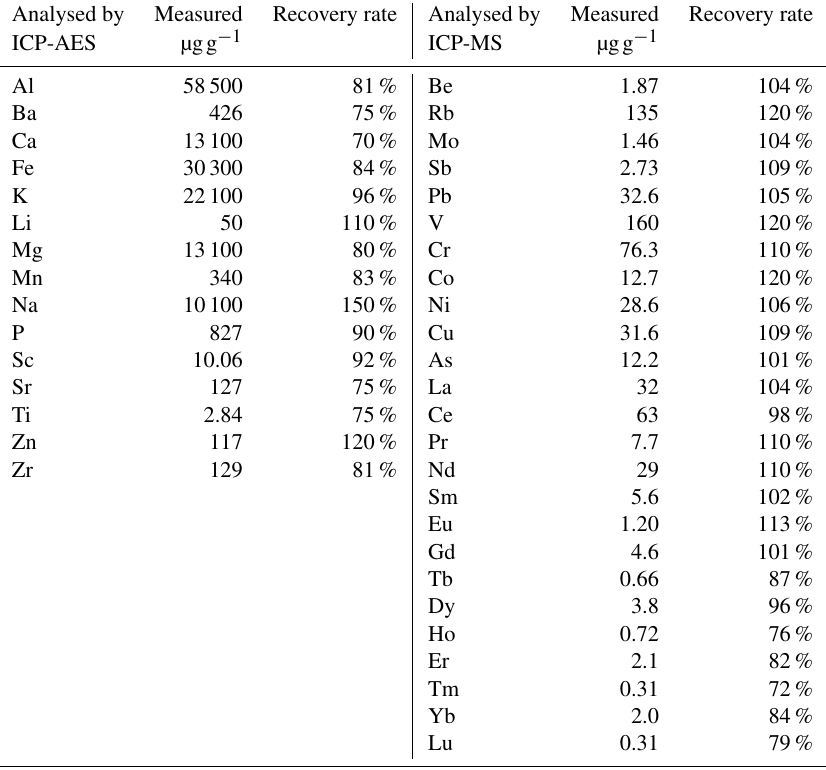
Table B2. SCO-1 recovery rates. Elements, except Na (recovery rate = 150%), have a recovery rate between 70% and 130%. The very low amount of geostandard used ( < 10mg) could explain the difference observed in recovery rates because subsampling heterogeneity is possible with such small